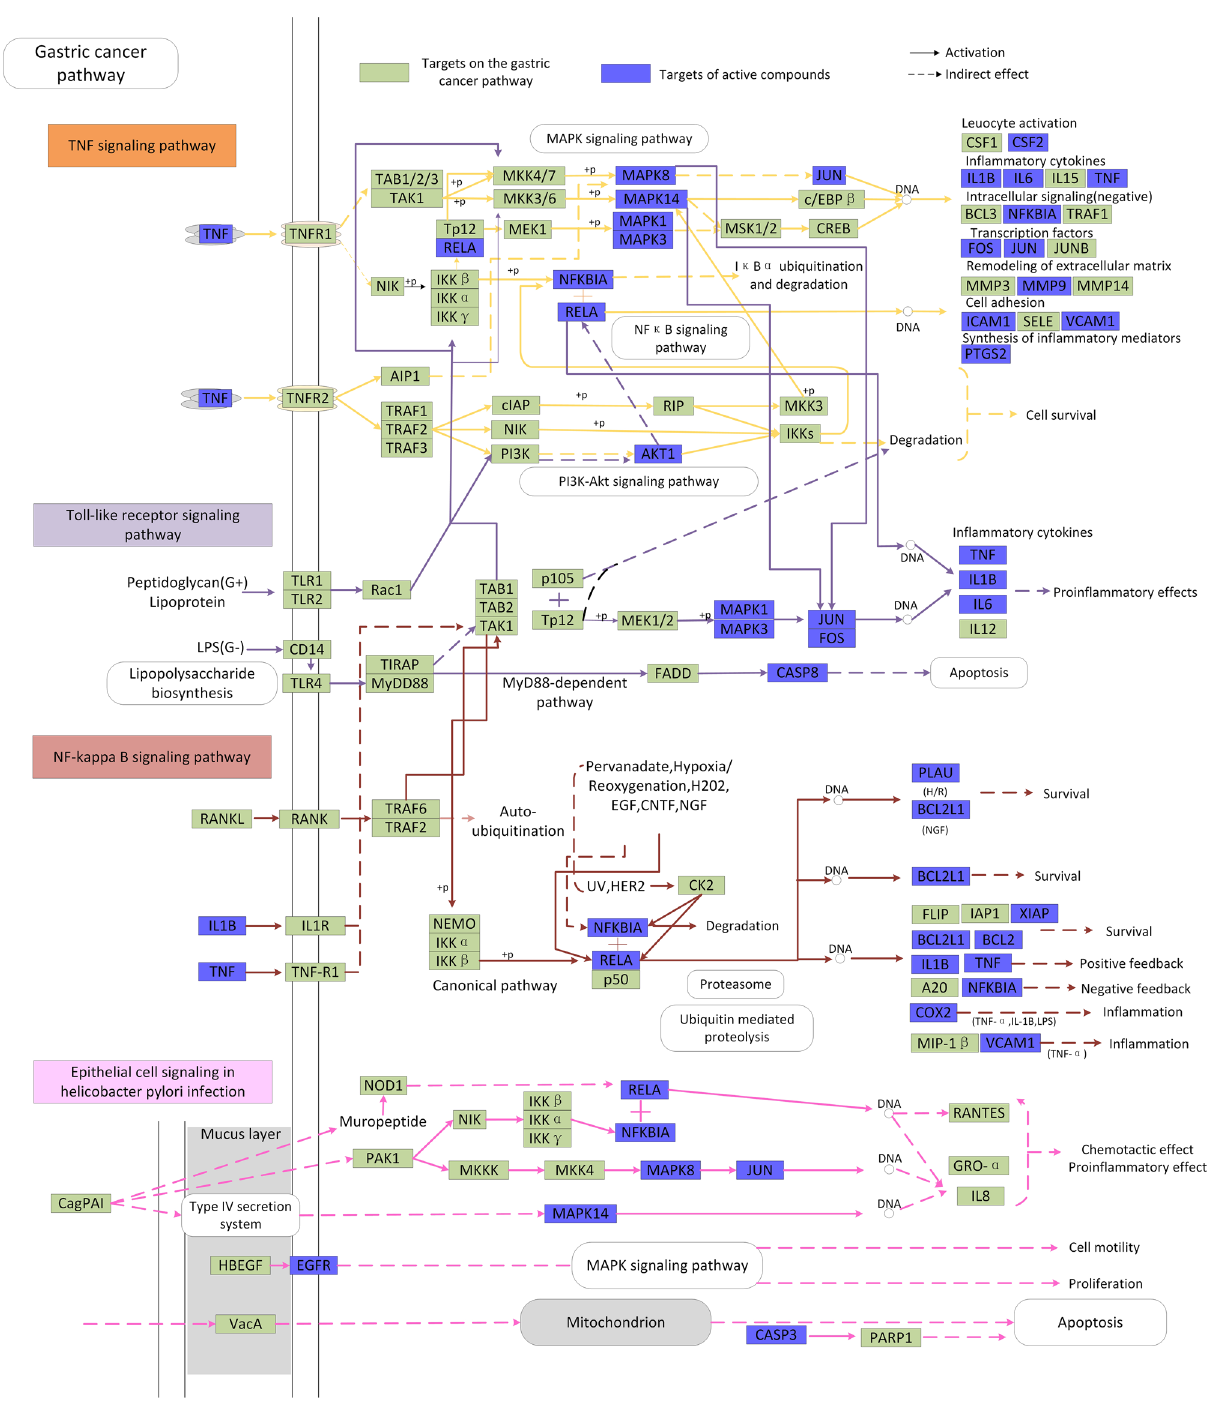
Figure 5. The gastric cancer pathway and therapeutic modules. The blue squares represented efficacy targets, the green squares represented the other targets in the gastric cancer pathway. Solid arrows indicated activation and dashed arrows indicated inhibition. Different pathways were represented by different